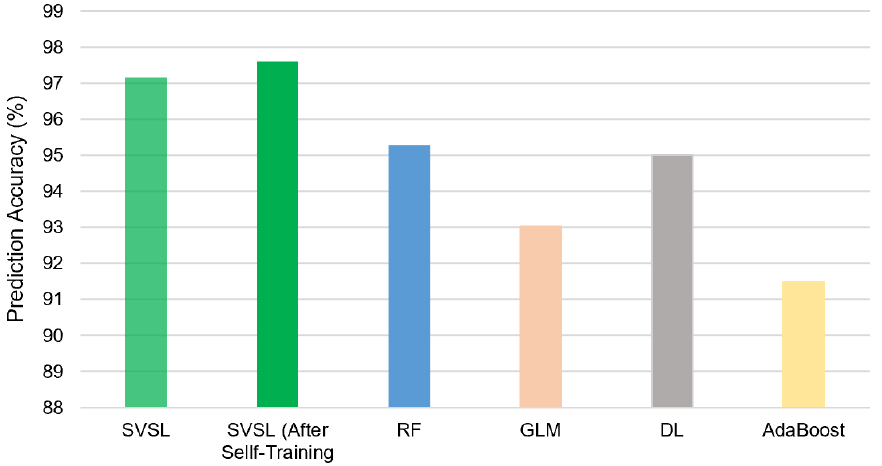
Figure 11. Prediction accuracy (%) of the SVSL methods, RF, GLM, DL, and AdaBoost.